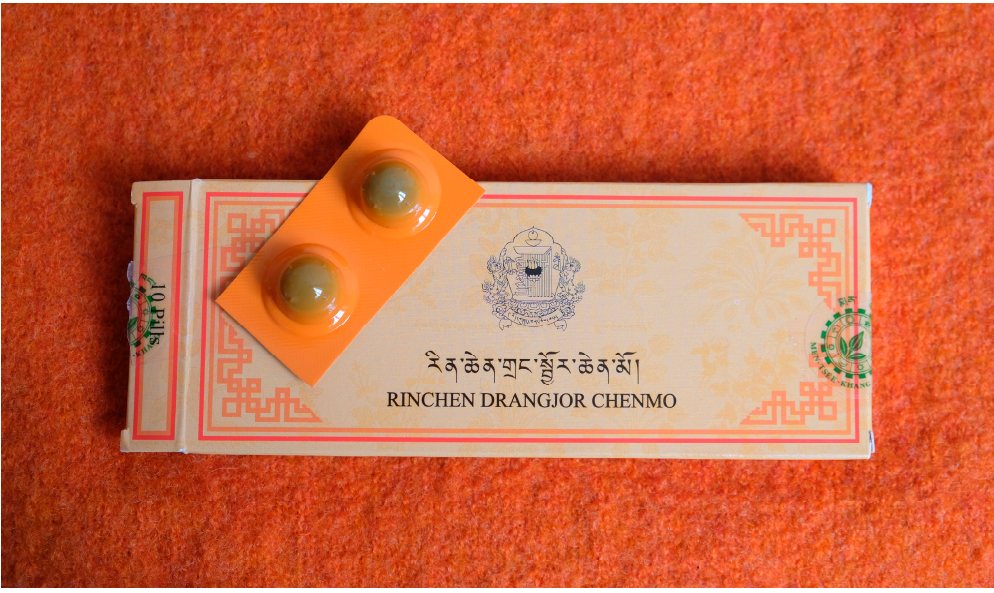
Figure 6. The precious pill Rinchen Drangjor, as packaged by the Men-Tsee-Khang in Dharamsala. Photo by